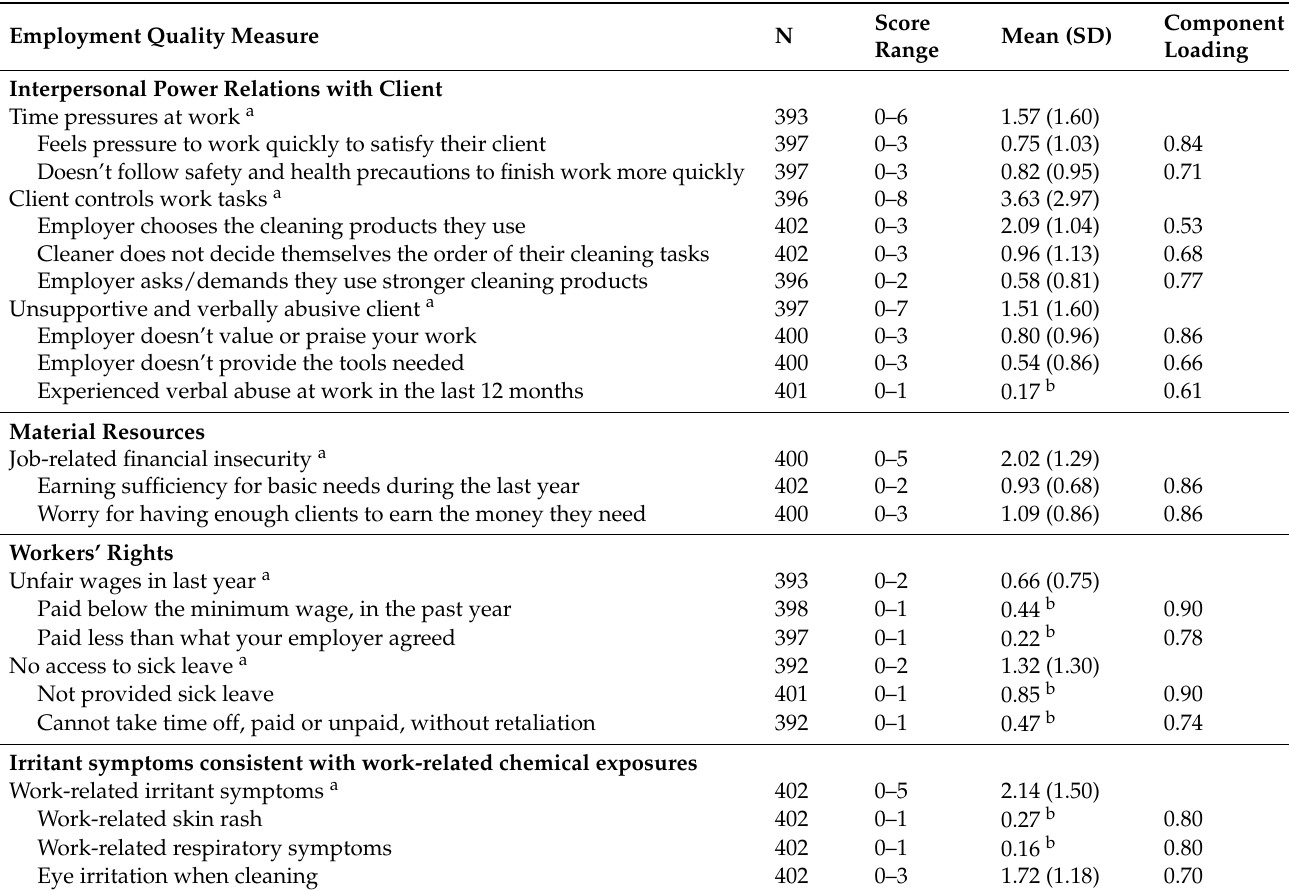
Table 4. Principal Component Analysis (PCA) Results for Employment Quality (EQ) and work- related irritant symptoms survey questions that could be combined into a single variable: Safe and Just Cleaners